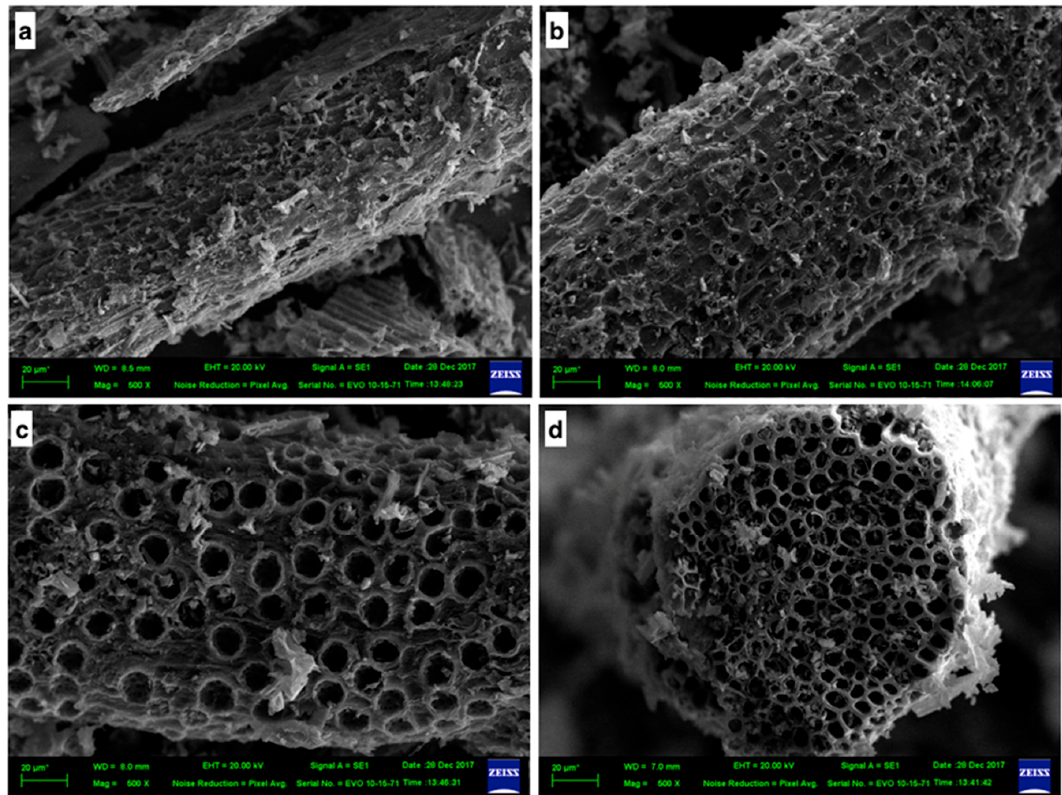
Figure 2. Scanning electron microscope (SEM) micrographs 500 µ m: ( a ) PMFs char, ( b ) PMFC obtained at microwave power of 700 W for 4 min using 2:1 activating agent ratio (S BET = 911 m 2 / g), ( c ) external surface of PMFC obtained at microwave power of 700 W for 6 min using 2:1 activating agent ratio (S BET = 991 m 2 /g), and ( d ) cross section of PMFCs obtained at microwave power of 700 W for 6 min using 2:1 activating agent ratio (S BET = 991 m 2 /g).